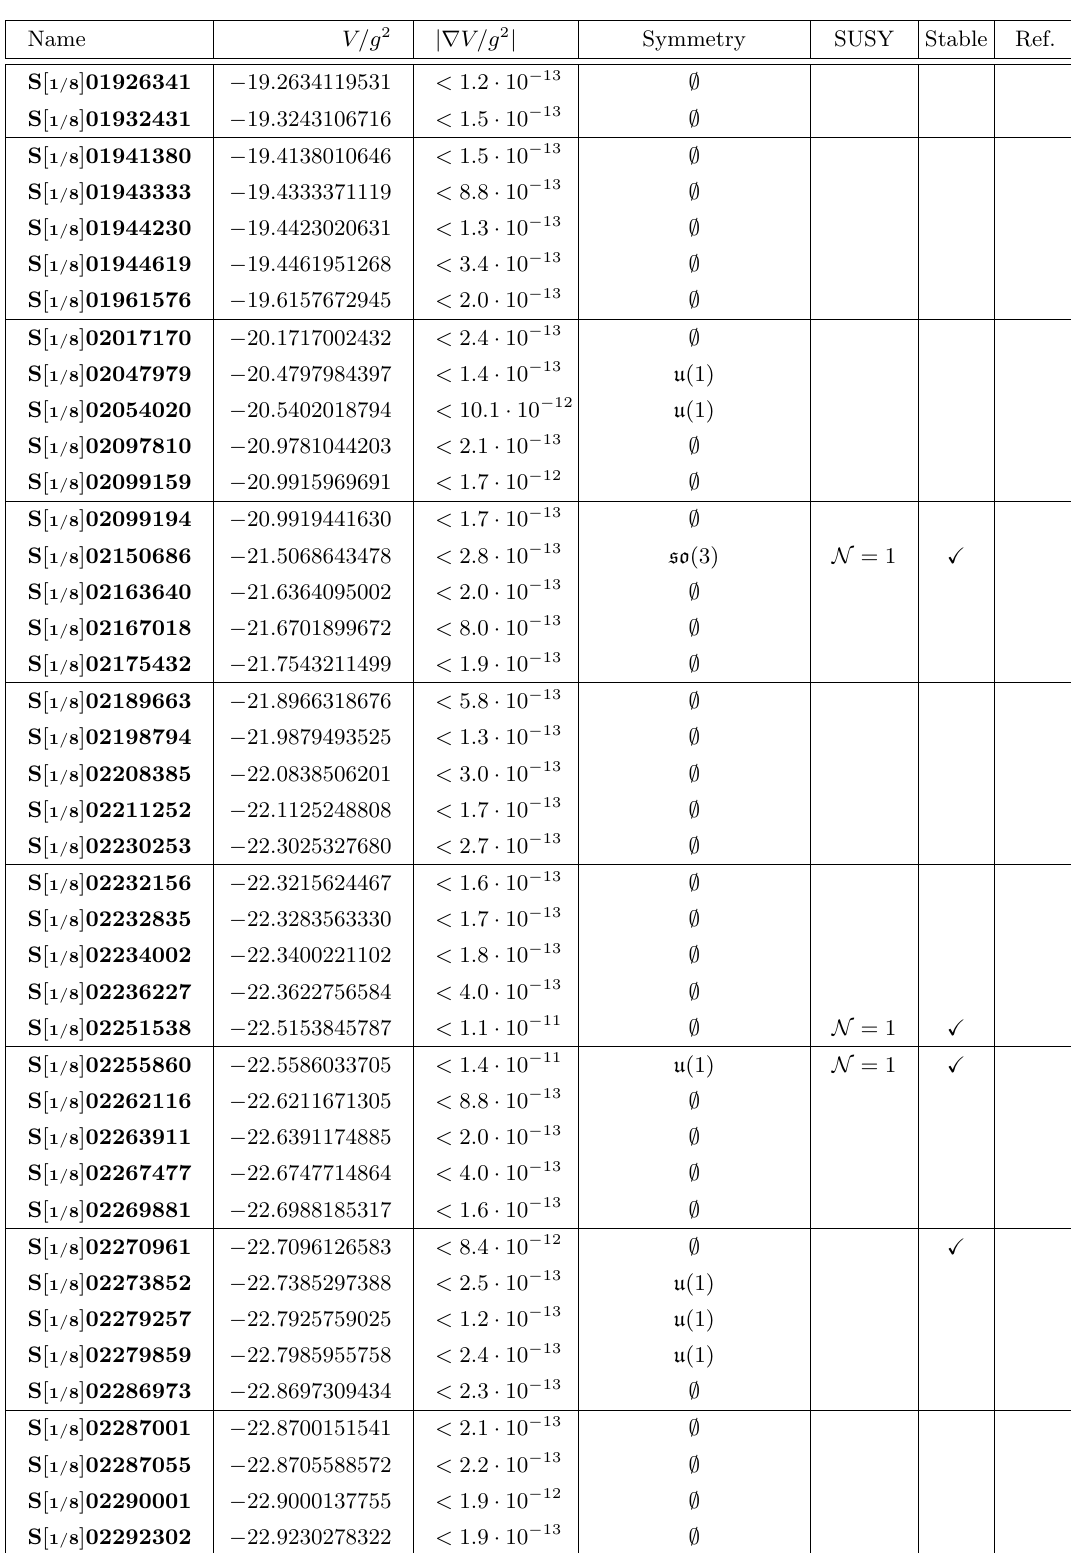
Table 1. Summary of vacua at ω = π/ 8